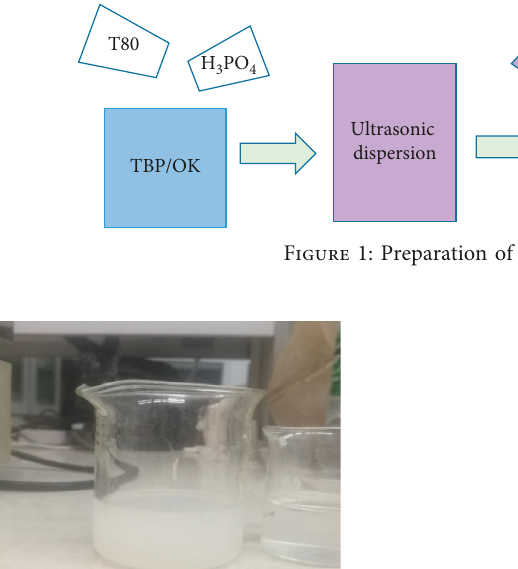
3 PO 4 emulsion.